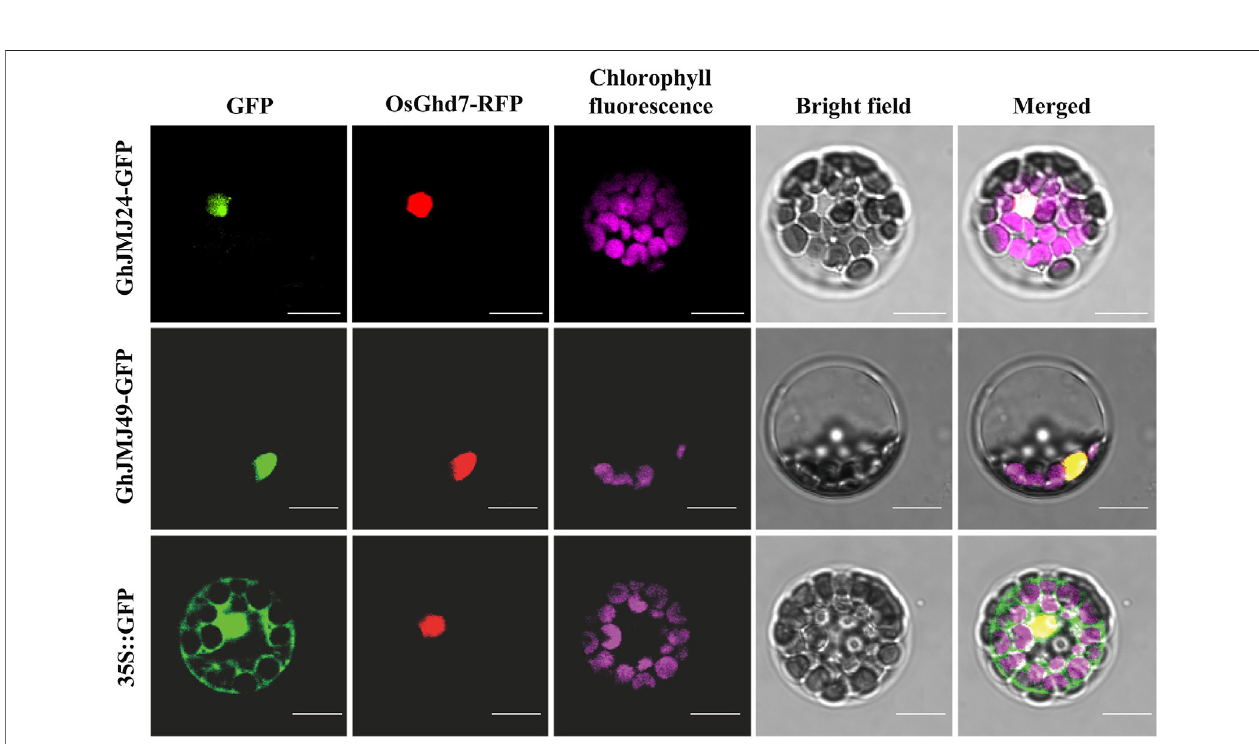
FIGURE 7 | Subcellular localization of GhJMJ24 and GhJMJ49 in Arabidopsis protoplasts. Recombinant plasmid 35S::GhJMJ24-GFP, 35S::GhJMJ49-GFP and the empty vector 35S::GFP were transfected separately into Arabidopsis protoplasts with nuclear marker 35S::OsGhd7-RFP. Fluorescence signals from GFP, RFP, chlorophyll auto fl uorescence (pseudo-colored purple) and the merged images are shown. Scale bars, 10 μ m.